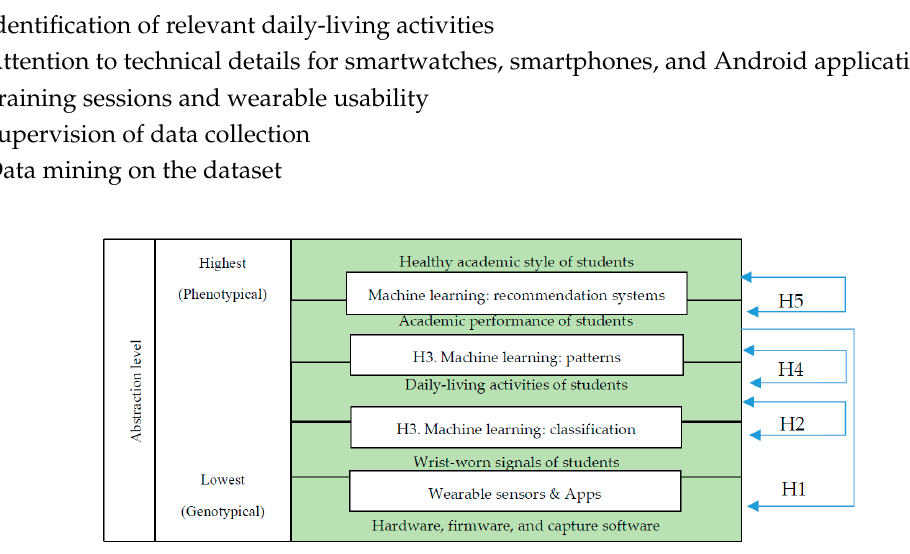
Figure 1. Hypotheses and relationships between smartwatch signals, daily activities, academic performance, and healthy academic style.